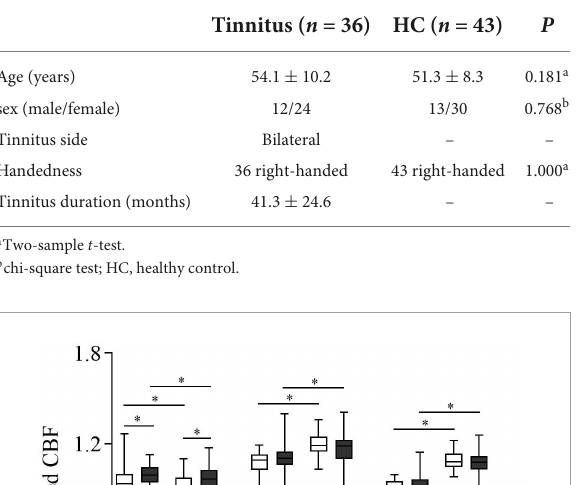
patients: P = 0.037), while the LI of the SAC and AAC were significantly lower than 0 (SAC: HCs, P < 0.001; patients, P = 0.001; AAC: HCs, P < 0.001; patients, P < 0.001). In addition, tinnitus patients had significantly lower LI in SAC than HCs ( P = 0.008), and no significant LI